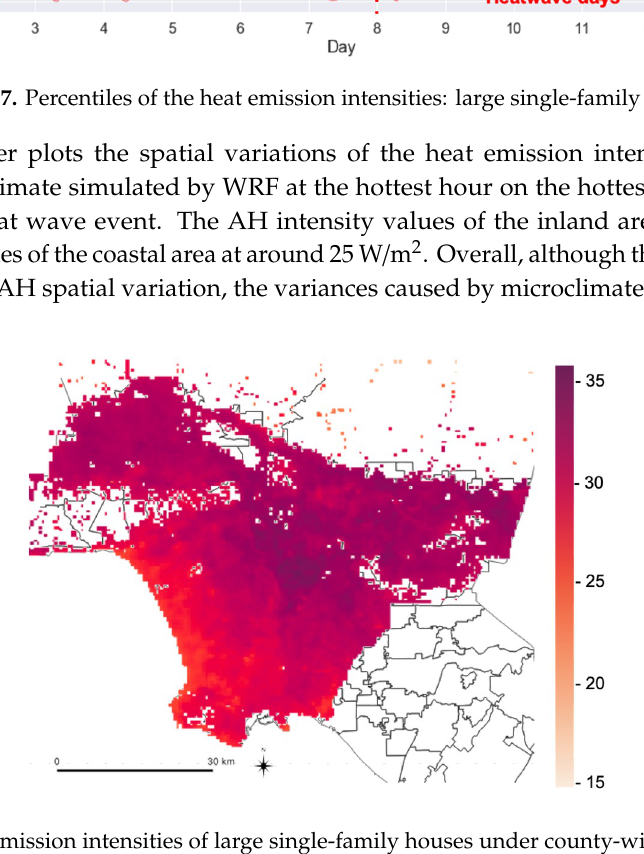
Figure 18. Heat emission intensities of large single-family houses under county-wide microclimate.